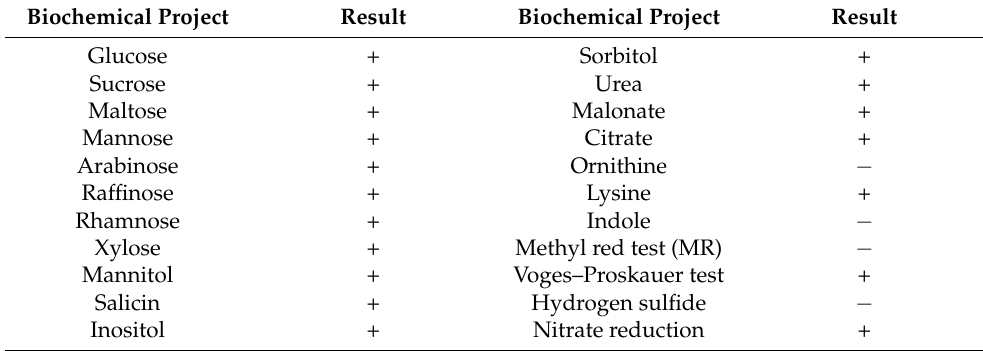
Table 2. Results of KPHN001 biochemical test.